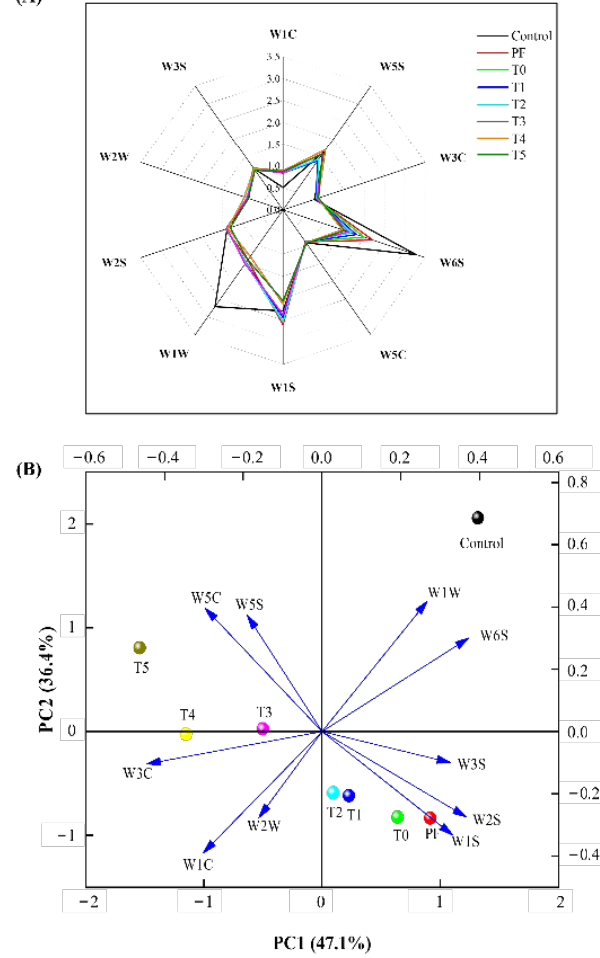
Figure 2. Radar chart ( A ) and principal component analysis ( B ) of the electronic nose data for phosphate-containing frankfurters or phosphate-free frankfurters added with the combination of L-Arg and PC. PF group: no added phosphate. T0 group: 0.15% PC and no added phosphate. T1 group: 0.15% PC + 0.025% L-Arg, and no added phosphate. T2 group: 0.15% PC + 0.05% L-Arg, and no added phosphate. T3 group: 0.15% PC + 0.075% L-Arg, and no added phosphate. T4 group: 0.15%